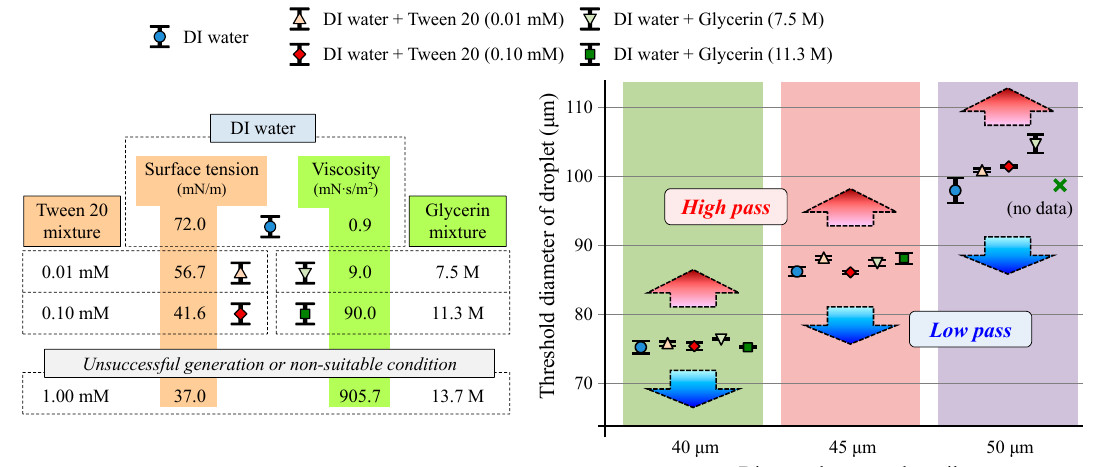
Figure 7. Threshold diameters of sorted droplets using different droplet phase materials by tuning surface tension or viscosity.